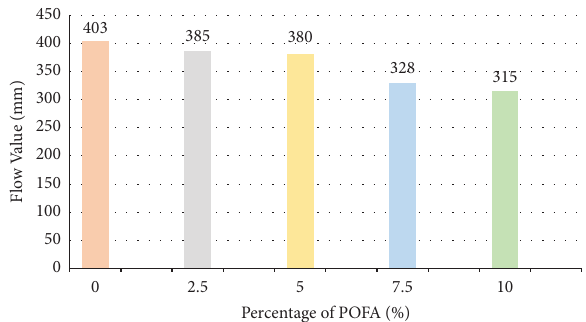
Figure 7: Flow value results on diferent percentages of POFA.